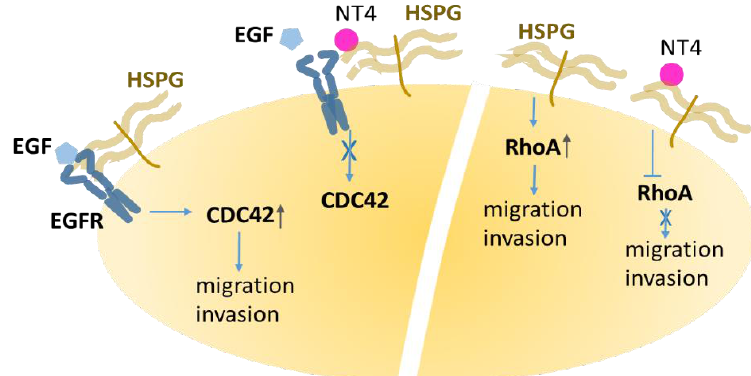
Figure 7. EGF binding to the receptor, assisted by heparan sulfate proteoglycans (HSPGs), triggers CDC42 activation. NT4 binding to HSPG disrupts the EGF-EGFR-HSPG triad and reduces CDC42 activation. Besides, NT4 dampens RhoA activation, without interference with EGF-EGFR systems, confirming the ability of HSPGs to directly modulate this GTPase.